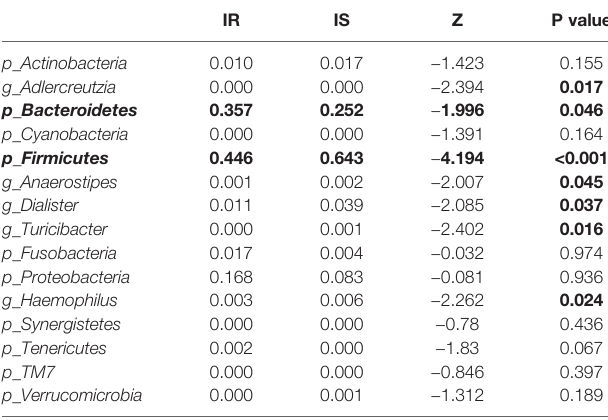
TABLE 2 | The mean relative abundance of gut microbiota in IS and IR subjects at phylum level.